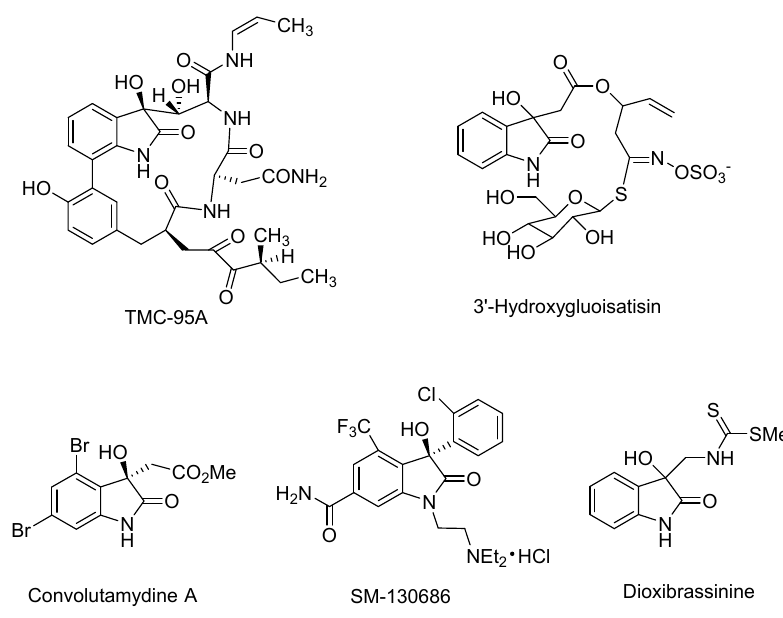
Figure 1. Representative examples of 3 ‐ substituted ‐ 3 ‐ hydroxy ‐ 2 ‐ oxindoles.